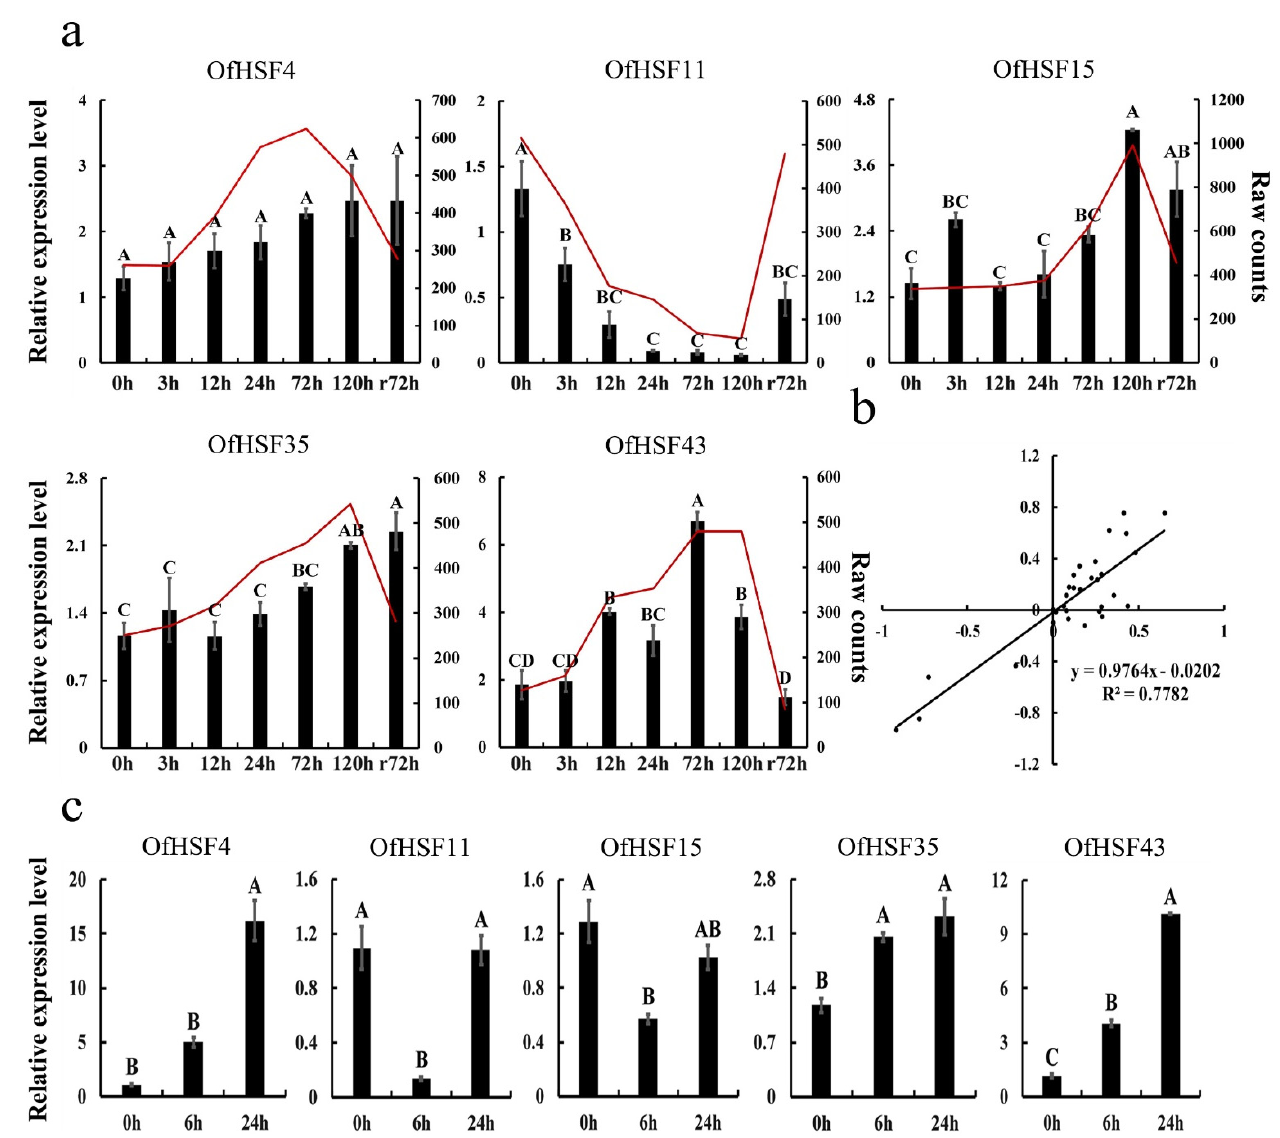
Figure 6. Expression profiles of the five selected OfHSF genes in response to stresses. ( a ) The relative expression levels of five selected OfHSF genes under cold-stress conditions. Black columns represent the qRT-PCR results and red lines represent raw counts. The error bars indicate the means ± SEs ( n = 3). Capital letters represent the significant differences as assessed by Duncan’s test at the 0.01 level. ( b ) Correlation analysis between the raw counts and qRT-PCR results. The black line represents the correlation trend line. ( c ) The relative expression levels of five selected OfHSF genes under heat-stress conditions.